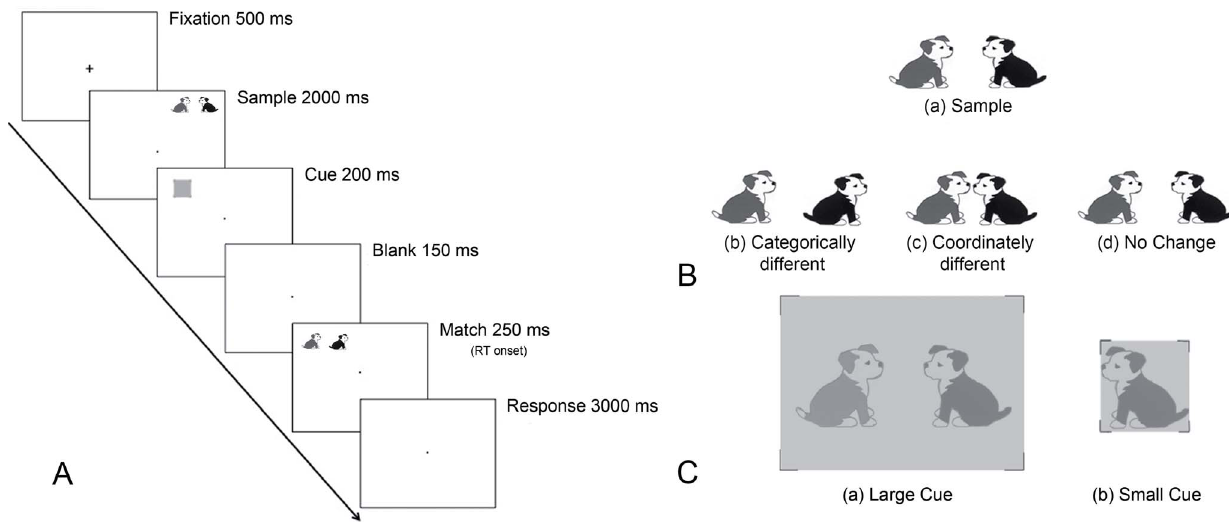
Figure 1. Experimental paradigm. A: Example of an experimental valid trial of the categorically (CAT) different condition with its timing; B: Example of sample stimulus (a) and matching stimulus when it is categorically different (b, CAT), coordinately different (c, COO) and identical (d, NoCh) to the sample stimulus; C: Attention window with large (a) and small cue (b).